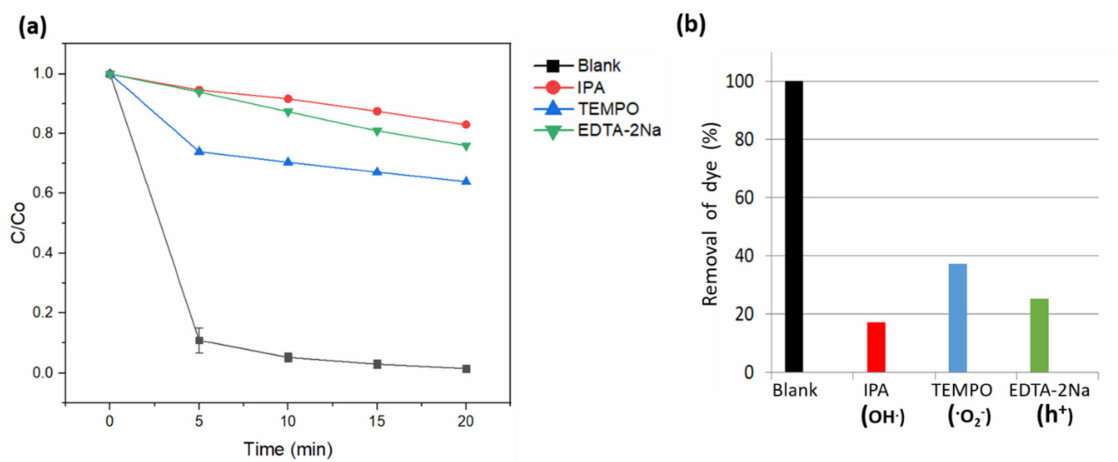
Figure 8. ( a ) The photodegradation of MB by the as-prepared C,N-doped FeBO 3 under simulated solar illumination in the presence of various scavengers: ( a ) a plot of C/Co; ( b ) a bar graph showing the percentage removal of